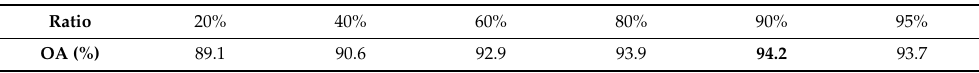
Table 11. Mask ratio selection. The bold denotes the best